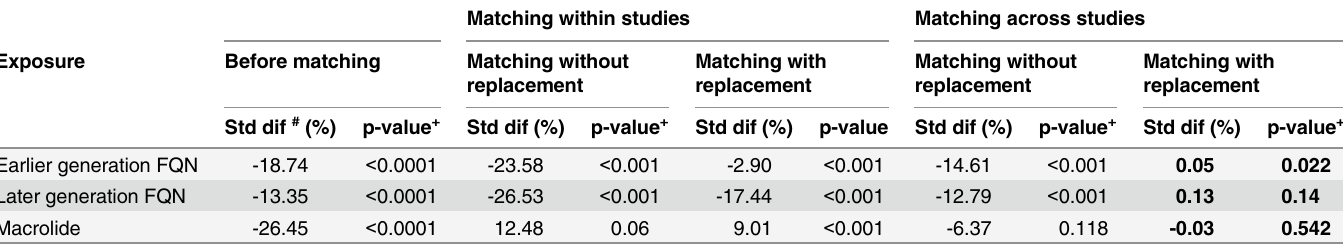
Table 3. Comparison of covariate balance before and after one to one matching across studies, with or without replacement, for each drug group, based upon standardized difference (%) of the logit of propensity score between groups. Exposure Before matching Matching without